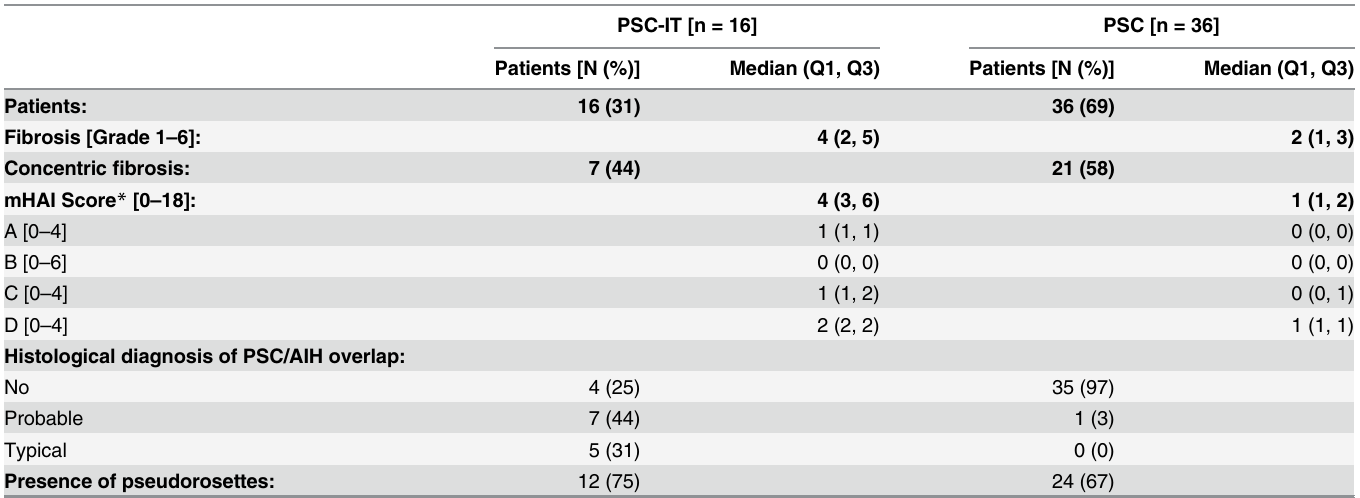
IT during the disease course of PSC [hazard ratio (HR) 3.6, p = 0.0274, Table 3]. Fig 1 high- lights two typical liver histologies of patients with a mHAI score greater and lower than 3 points. Simplified AIH score. The simplified AIH score can be used in clinical practice to aid the diagnosis of classical AIH.(6) Hence, we evaluated whether this score was associated with sub- sequent IT in patients with PSC. Using a cut-off value of more than 5 points – determining a Table 2. Histological characteristics in patients with and without IT. PSC-IT [n = 16] PSC [n =